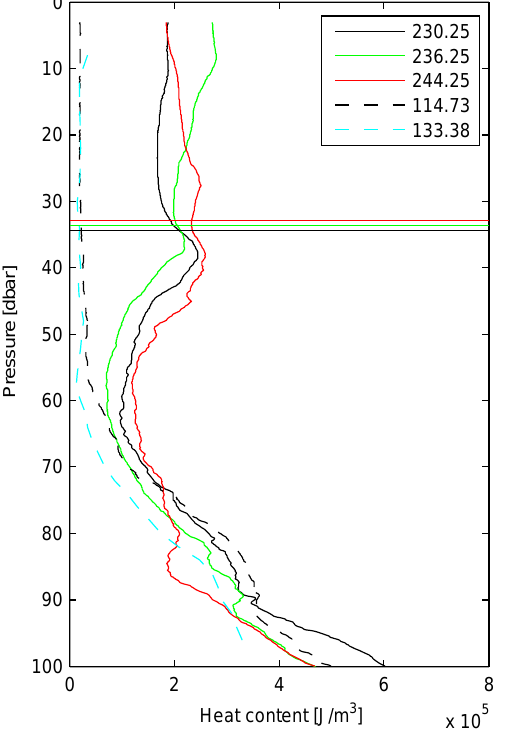
Fig. 10. Heat content of the upper 100m for the Barneo08 experi- ment, the ITP 19 data and at beginning, middle and end of the AS- COS experiment, all profiles obtained as described in Fig. 5. Hori- zontal lines indicate mixed layer depths for the average